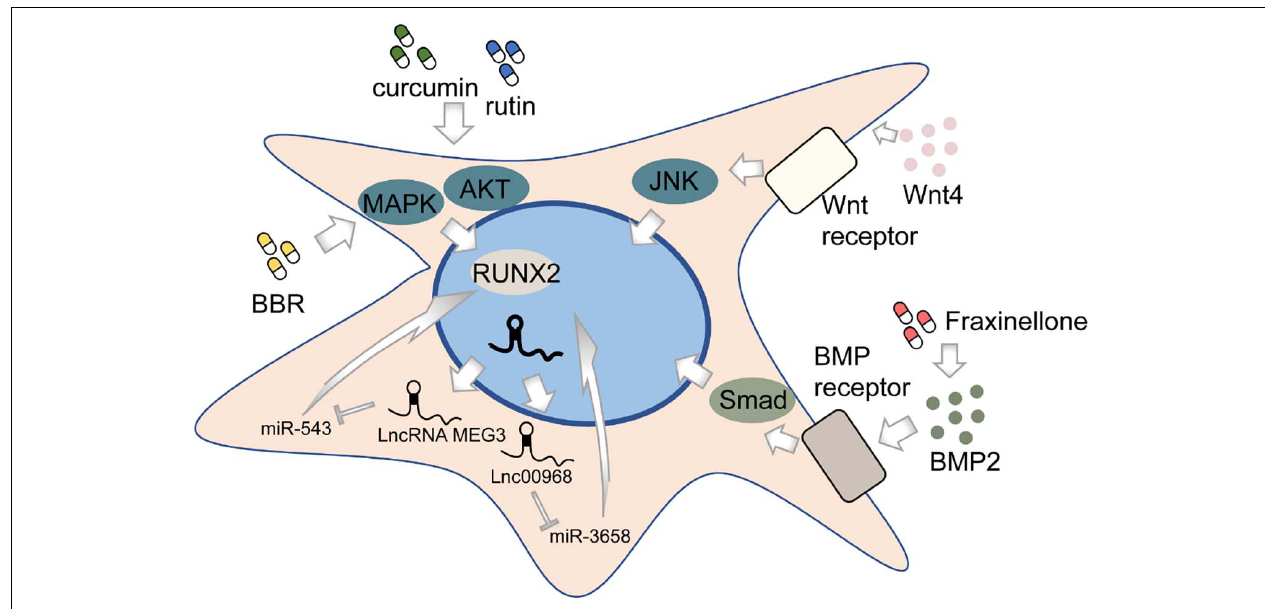
FIGURE 2 | The regulation of osteogenic differentiation of